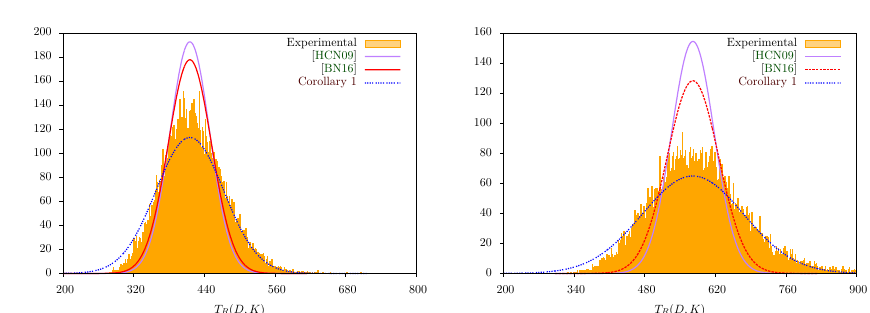
Figure 5: Comparison between the experimental distribution of T ( D, K ) and normal distributions with mean B‘ + NC and different variances recalled in this paper. Left with N = 2 14 . Right with N = 2 15 . Experiments in the KP